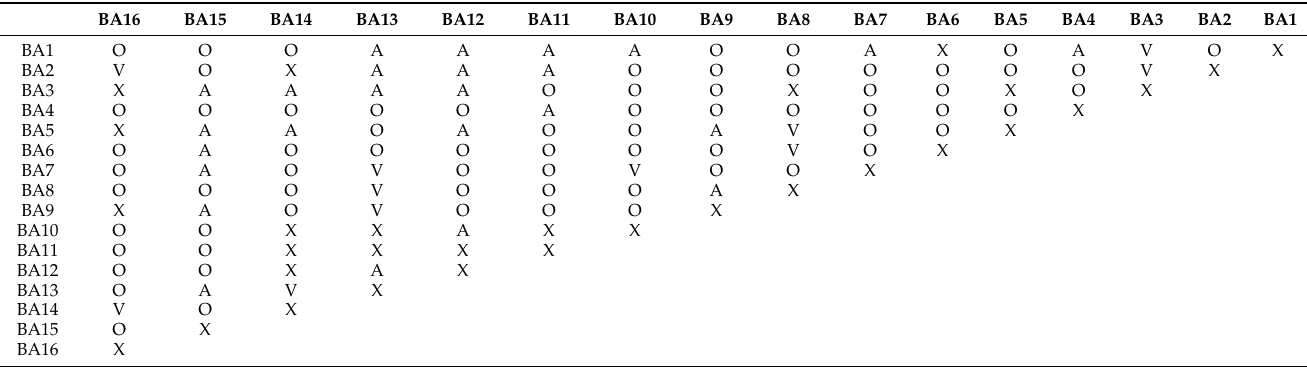
Table 5. Structural self-interaction matrix (SSIM) barriers to BIM-based LCA.